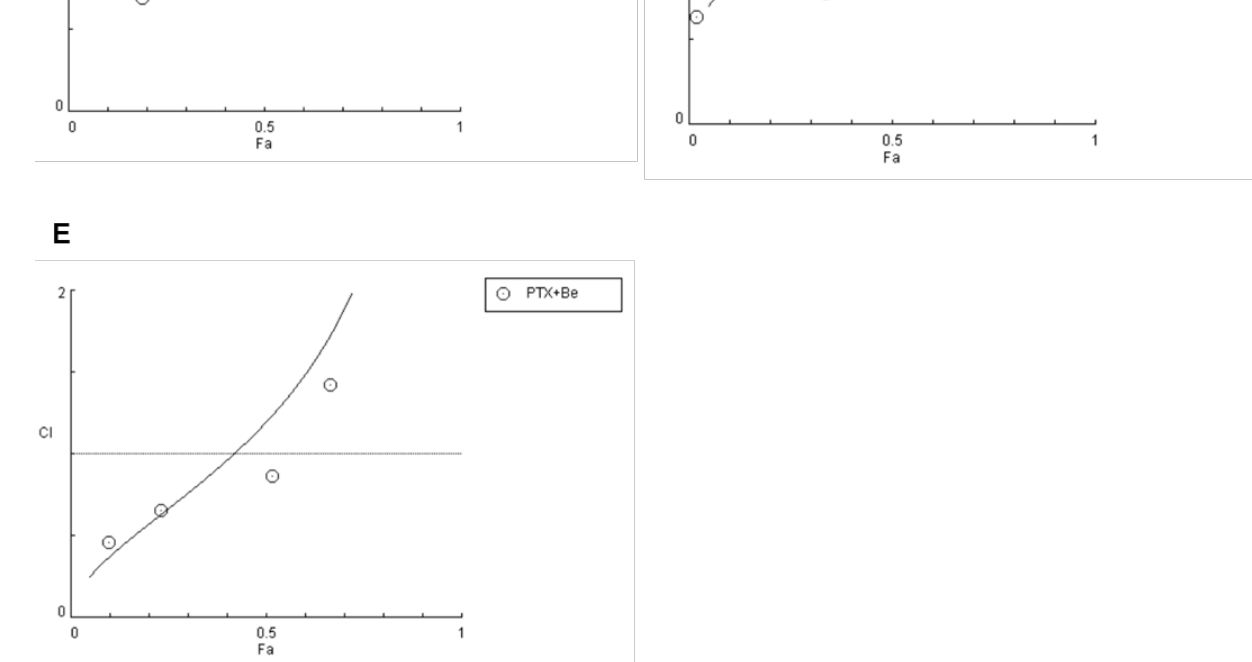
Figure 17. Chou-Talalay method Fa-CI plot of PTX plus fluoxetine ( A ), sertraline ( B ), thioridazine ( C ), fluphenazine ( D ) and benztropine ( E ). CI was plotted on the y -axis as a function of effect level (Fa) on the x -axis to evaluate drug synergism. CI < 1, CI = 1 and CI > 1 refers to synergism, additivity and antagonism, respectively.